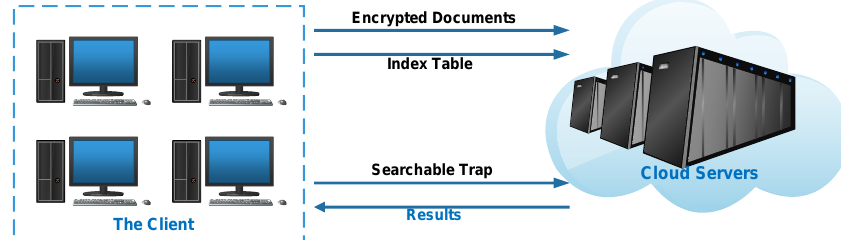
Figure 1. The system model of our